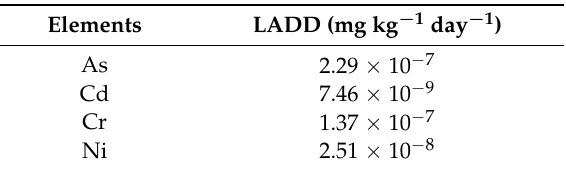
Table 5. The lifetime average daily dose (LADD) of cancer elements via inhalation pathway (Unit: mg kg − 1 day − 1